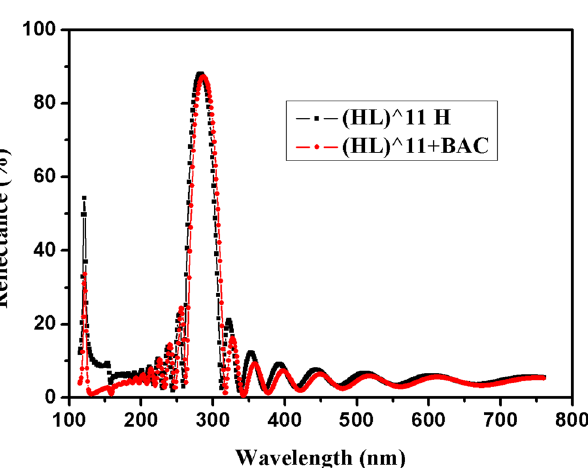
Figure 2. Theoretical reflectance curve of our initial design. The multilayer structure is (HL)^11 H, the incidence is 45°, the substrate is fused silica, backside reflectance is not taken into the calculation, and the reference wavelength is 283 nm.